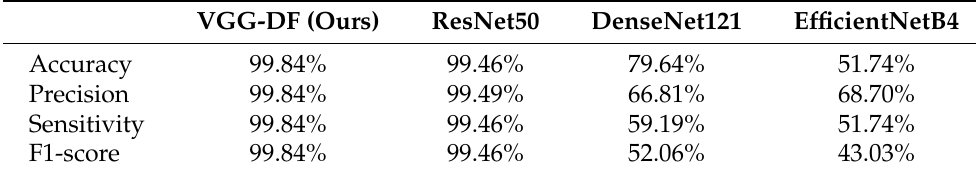
Table 5. Results of different transfer learning models trained on the dataset that combines original and synthetic